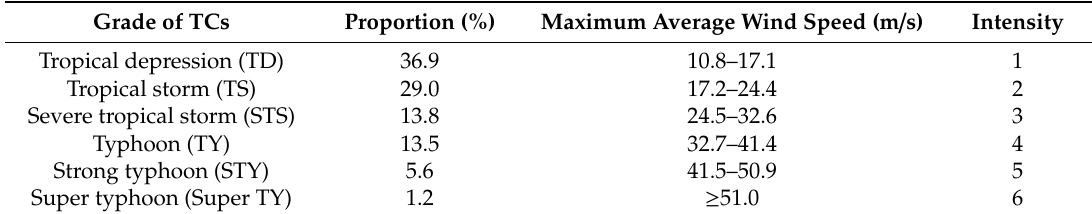
Table 1. Grades of TCs and proportion over 18 years (2001–2018).